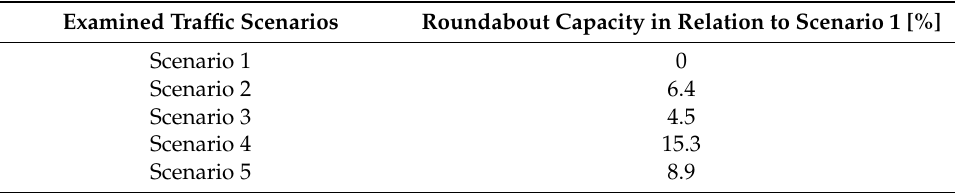
Table 5. Mean number of iterations and median of the iteration quantity.